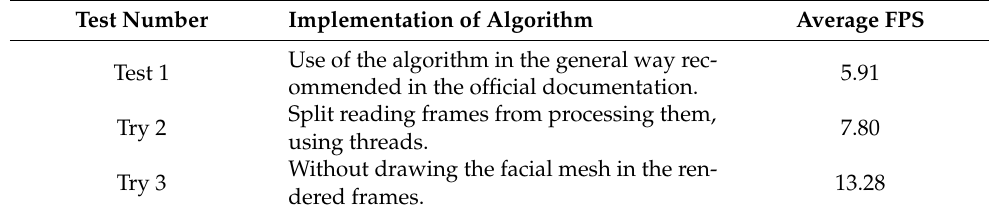
Table 6. Performance tests for different implementations of MediaPipe.